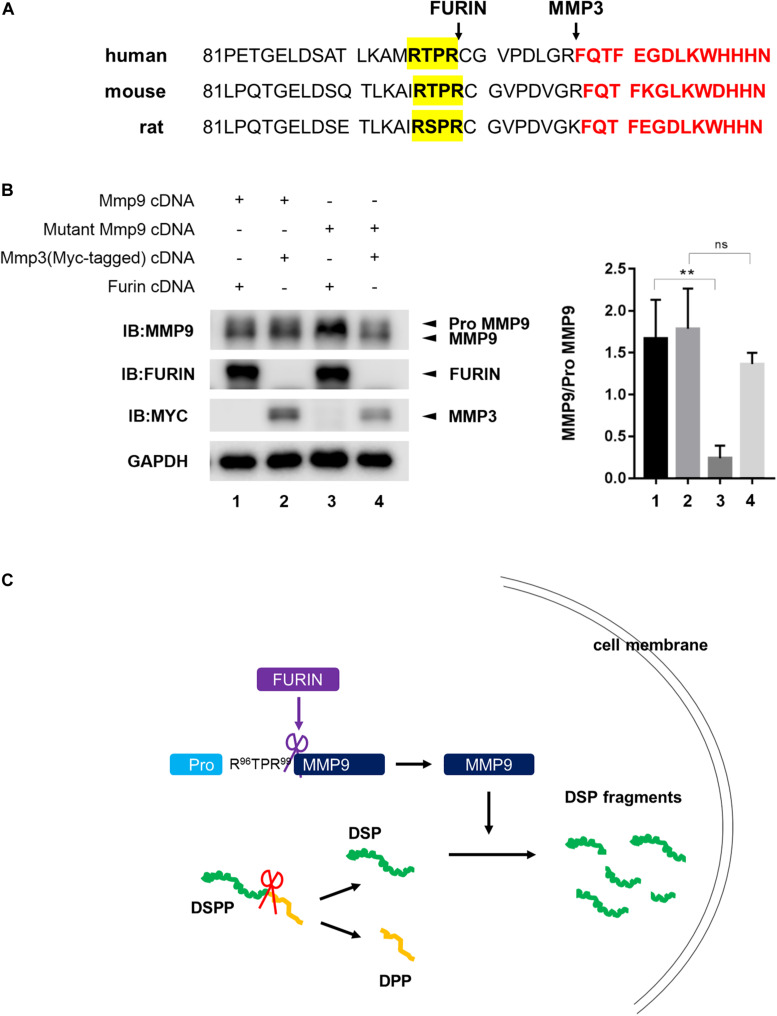
FURIN activated MMP9 through cleavage at R96TPR99. (A) The predicted cleavage sites of proMMP9 by FURIN in human, mouse, and rat (highlighted by yellow). The recognized cleavage sites of proMMP9 by MMP3 were also marked. Red font showed starting amino acid sequences of activated MMP9. (B) The proMMP9 and mutant proMMP9 with R96TPR99 substituted by A96AAA99 were separately overexpressed in HEK293E cells together with FURIN (lanes 1 and 3) or MMP3 (lanes 2 and 4). Cell lysates were examined by western blotting analysis and the ratio of MMP9 to proMMP9 was quantified. A significant lower ratio of MMP9 to proMMP9 was found in lane 3 compared with lane 1, indicating that FURIN failed to cleave the mutant proMMP9. But the ratio of MMP9 to proMMP9 did not change in lane 4 compared with lane 2, indicating that this mutation of proMMP9 did not affect its cleavage by MMP3. **P = 0.0073, ns P > 0.05. (C) Schematic model shows that MMP9 activated by FURIN cleaves DSP intracellularly.